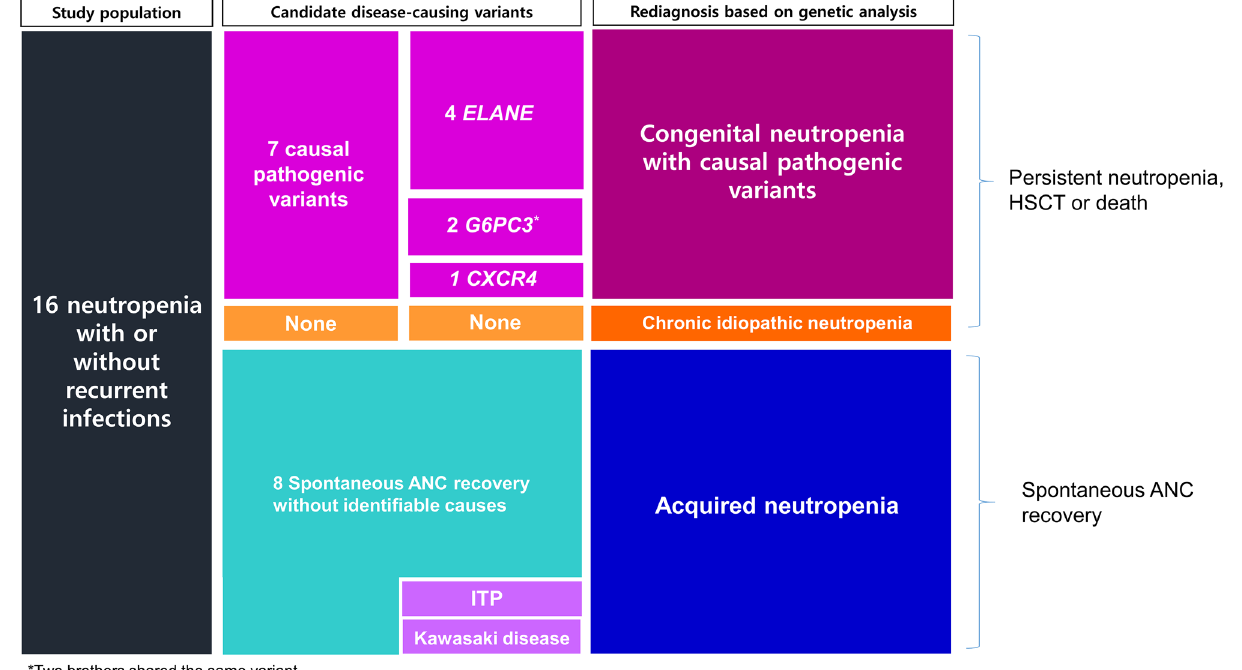
Figure 2. Re-diagnosis of 16 neutropenia patients based on genetic analysis. Seven patients with pathogenic variants in ELANE , G6PC3 and CXCR4 were diagnosed with CN with causal pathogenic variants. One patient harbored no pathogenic variant and was classified as chronic idiopathic neutropenia. Other 8 patients who achieved spontaneous ANC recovery were re-diagnosed with acquired neutropenia. Two out of the 5 patients had a history of immune thrombocytopenia and Kawasaki disease, respectively, and both were treated with IVIG. ITP, immune thrombocytopenic severe infection, whereas 4 (50.0%) patients experienced neutropenic or non-neutropenic fever with non-severe infection. Four (50.0%) patients showed maturation block at the band stage, whereas 4 (50.0%) patients showed no maturation arrest. One of the 7 patients (P-02) had a history of immune thrombocytopenia and received intravenous immunoglobulin (IVIG) treatment. Fluorescent antinuclear antibody test revealed weak positivity. Another patient (P-07) had a history of Kawasaki disease and received IVIG treatment. She had an older brother who suffered from recurrent pneumonia in childhood but became healthy later. Meanwhile, there was a patient (P-16) who had the constitutional karyotype of 46,XX,add(14)(p13), the significance of which is not clear. Re‑diagnosis of 16 neutropenia patients based on genetic analysis. The causal pathogenic vari- ants were detected in 7 patients and included 4 mutations in ELANE , 2 in G6PC3 and 1 in CXCR4 . They were re-diagnosed with CN with causal pathogenic variants. A patient with intermittent neutropenia for more than 3 years without identifiable causes was classified into chronic idiopathic neutropenia. The 8 remaining patients were re-diagnosed as having acquired neutropenia (Fig. 2). Genotype–BM histology correlations. Based on the genotyping results, we examined the relationship between genotype and BM histology, mainly focusing on maturation arrest and myelokathexis. Early maturation arrest at the promyelocyte or myelocyte stage was characteristic for ELANE mutations. The CXCR4 mutation was associated with myelokathexis with MPO grade 2 and G6PC3 mutations with BM retention with MPO grade 1. Maturation block at the band neutrophil stage was observed in the chronic idiopathic neutropenia patient (P-01) and 4 patients (P-02, P-04, P-07 and P-09) who were re-diagnosed with acquired neutropenia. The 4 patients with acquired neutropenia showed normal maturation with no myelokathexis (Supplementary Fig. S9). We analyzed the distribution of MPO-positive cells, MPO grade and M:E ratio in the context of genetic vari- ants. MPO-positive cells ranged from 20 to 60% in the patients with acquired neutropenia. Among patients with pathogenic ELANE mutations 3 showed 10%–30% MPO-positive cells and 1 patient showed 40%–50%. Three patients whose BM displayed myelokathexis and who had pathogenic G6PC3 and CXCR4 mutations showed 40%–50% MPO-positive cells. Three patients with pathogenic ELANE mutations showed various distribution of MPO grades. BM of the patient with a pathogenic CXCR4 mutation showed MPO grade 2, whereas BM of patients with G6PC3 mutations showed MPO grade 1. The M:E ratio of patients with ELANE mutations ranged from 0.5 to 1.5, which was lower than normal. That of the patients with G6PC3 mutations was 1.5–2.5, and that of the patient with a CXCR4 mutation was increased to 7.5–8.5 (Fig. 3).